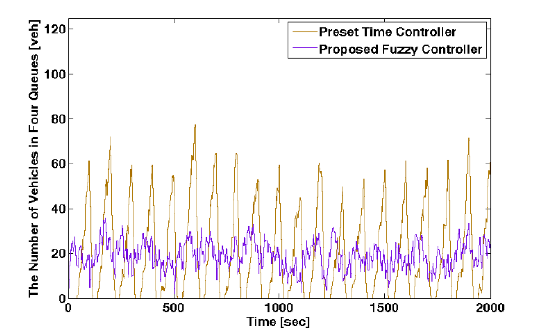
Figure 10. The number of vehicles in four legs in B